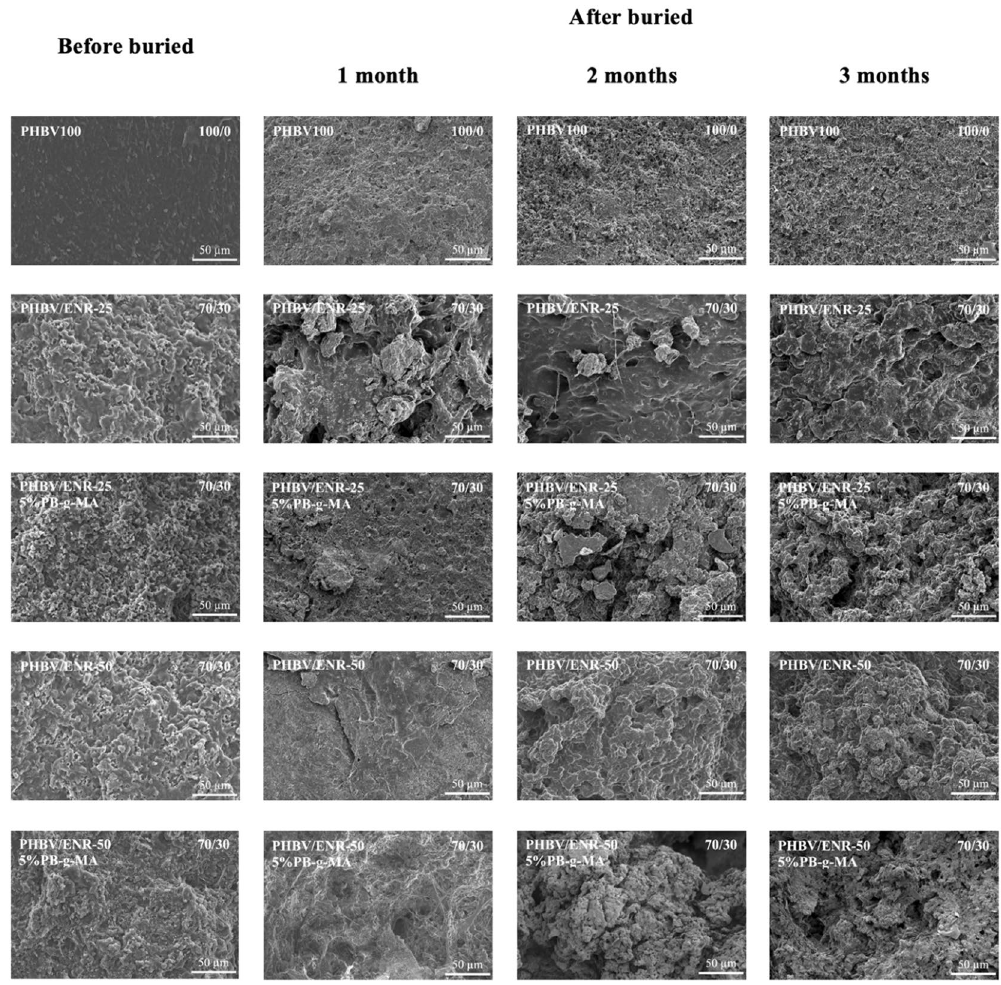
Figure 10. Representative SEM images of the neat PHBV, 70/30 PHBV/ENR-25 blends, and 70/30 PHBV/ENR- 50 blends, with and without 5wt%